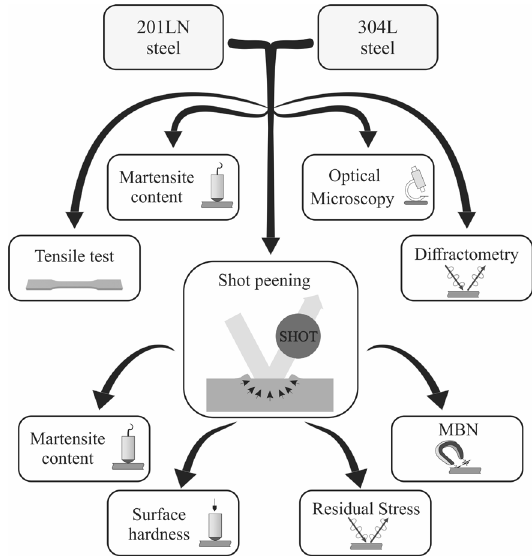
Figure 1. Flow chart describing the performed tests.